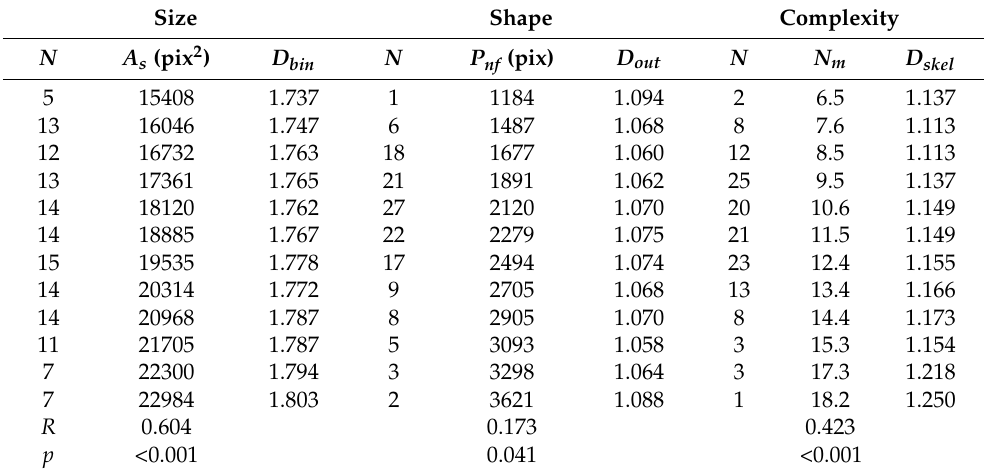
Table 1. Mean values of computational ( A s , P nf and N m ) and monfractal ( D bin , D out and D skel ) parameters in 12 intervals. The symbol N shows the number of images in each interval. In contrast, signs R and p show the Spearman correlation coefficients and significance level,